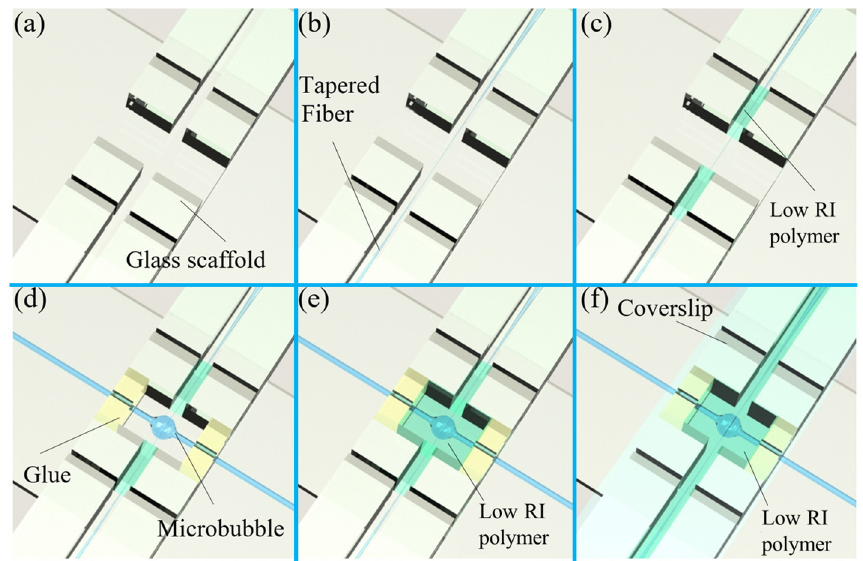
Figure 6. Packing process of a microbubble resonator: ( a ) a glass scaffold for holding the coupling system; ( b , c ) fixation of the tapered fiber; ( d ) fixation of the microbubble resonator; ( e ) wrapping the optical coupling region with low-RI polymer; ( f ) placement of a coverslip on the glass scaffold.